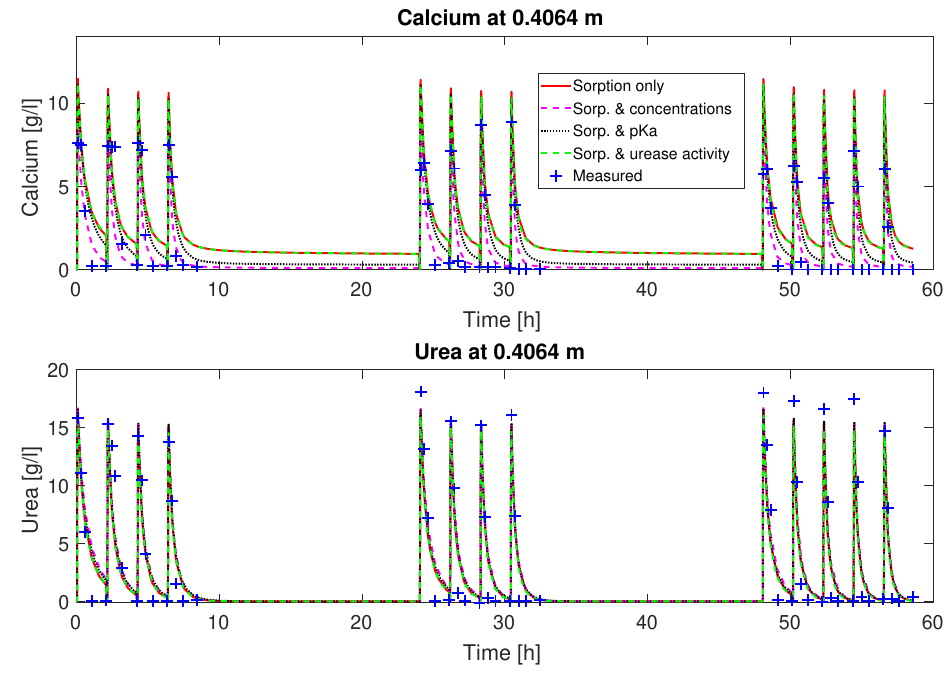
Figure 3. Comparison of the results of the model calibration attempts to the concentration measurements at 40.64 cm from the inlet for column experiment #1 (0.33 M mineralization medium